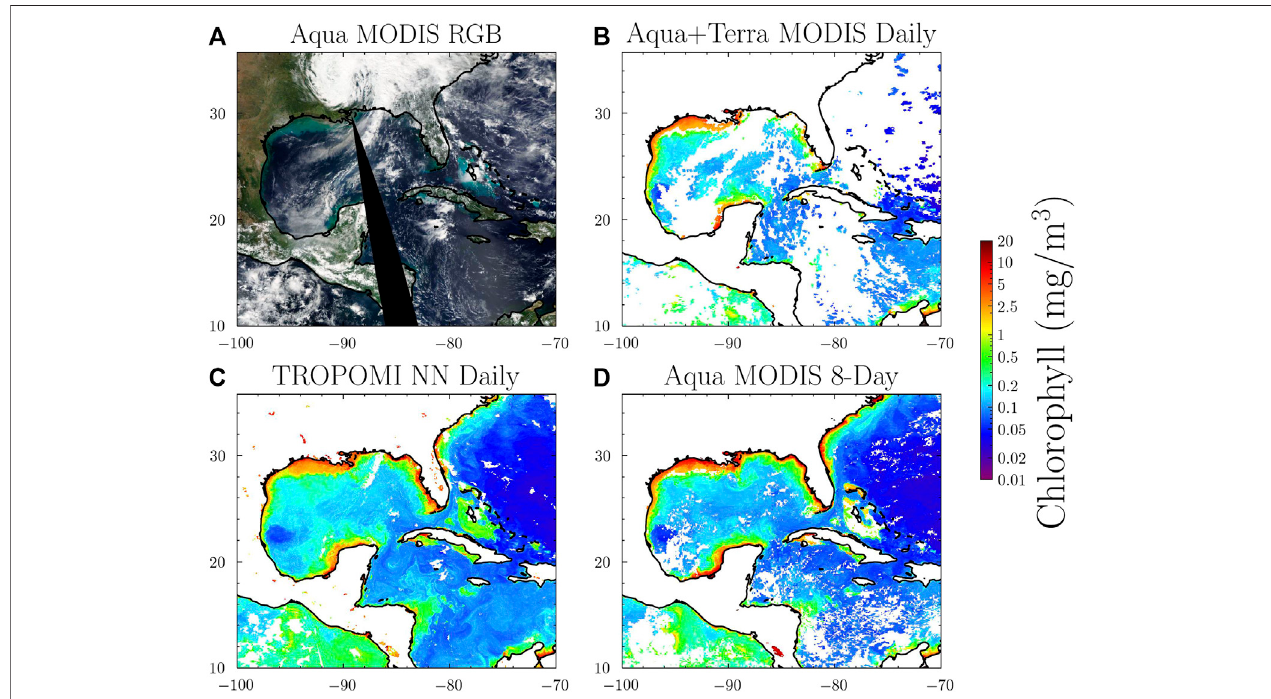
FIGURE 11| Chlorophyll retrievals in the Gulfof Mexico for 10 October 2020. (A) shows a true color image from MODIS Aqua, (B) shows MODIS-Aqua daily 4 km retrieval, (C) shows TROPOMI machine learning – based chlorophyll, and (D) shows MODIS-Aqua 8-day composite of chlorophyll.